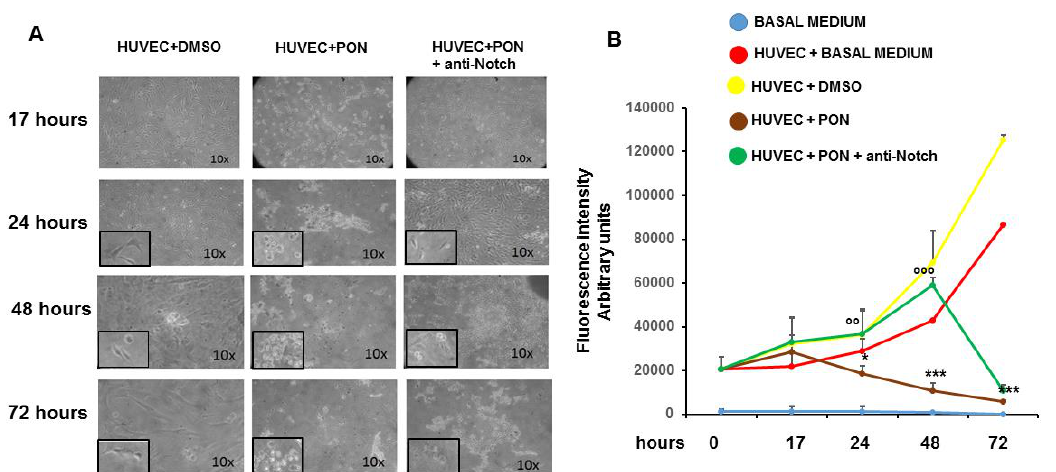
Figure 1. Effect of ponatinib and Notch-1 signaling inhibition on endothelial proliferation . Human umbilical endothelial cells (HUVECs) were plated at densities of 15,000 per well in 96-well plates and treated with 1.7 nM ponatinib or Dimethyl Sulfoxide (DMSO) for 17 to 72 h, in the presence or absence of 1 μg/mL of neutralizing factor anti-Notch-1 antibody. At the end of each time point, fluorescence intensities were measured with a fluorescence microplate reader using excitation at 485 nm and fluorescence detection at 530 nm. Representative microphotographs showing the effect of ponatinib and Notch-1 signaling inhibition on endothelial proliferation at 10× magnitude, are shown in Panel ( A ). Insets show the cells at 20× magnitude. Quantitative data (panel ( B )) are presented as mean ± standard deviation of fluorescence intensity arbitrary units. n = 3 independent experiments, with at least 7 replicates (culture dishes) per each group. * p < 0.05, *** p < 0.001 ponatinib treated vs. control